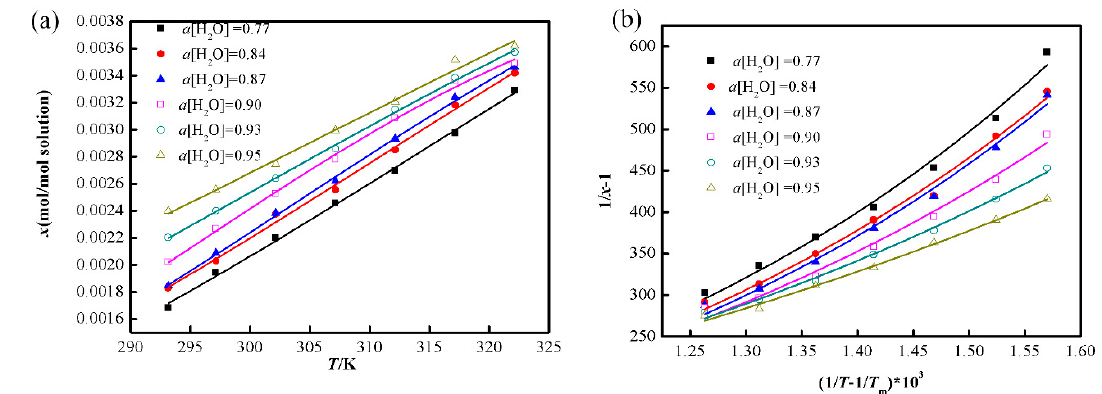
Figure 2. Mole fraction of L-Phe in methanol-water solvent mixtures calculated by Apelblat equation ( a ) and λ h equation ( b ). Table 2. Regressed parameters ARD and RMSD for L-Phe in different water activities by Apelblat and λ h Equation .